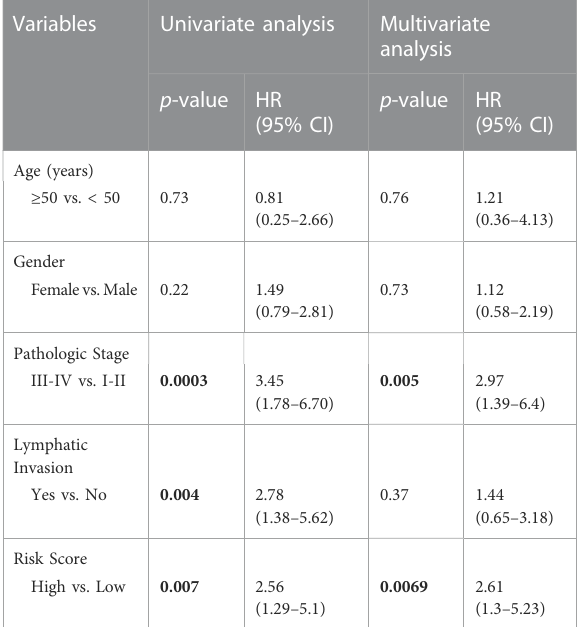
TABLE 2 Univariate and multivariate analysis associated with CRC overall survival.